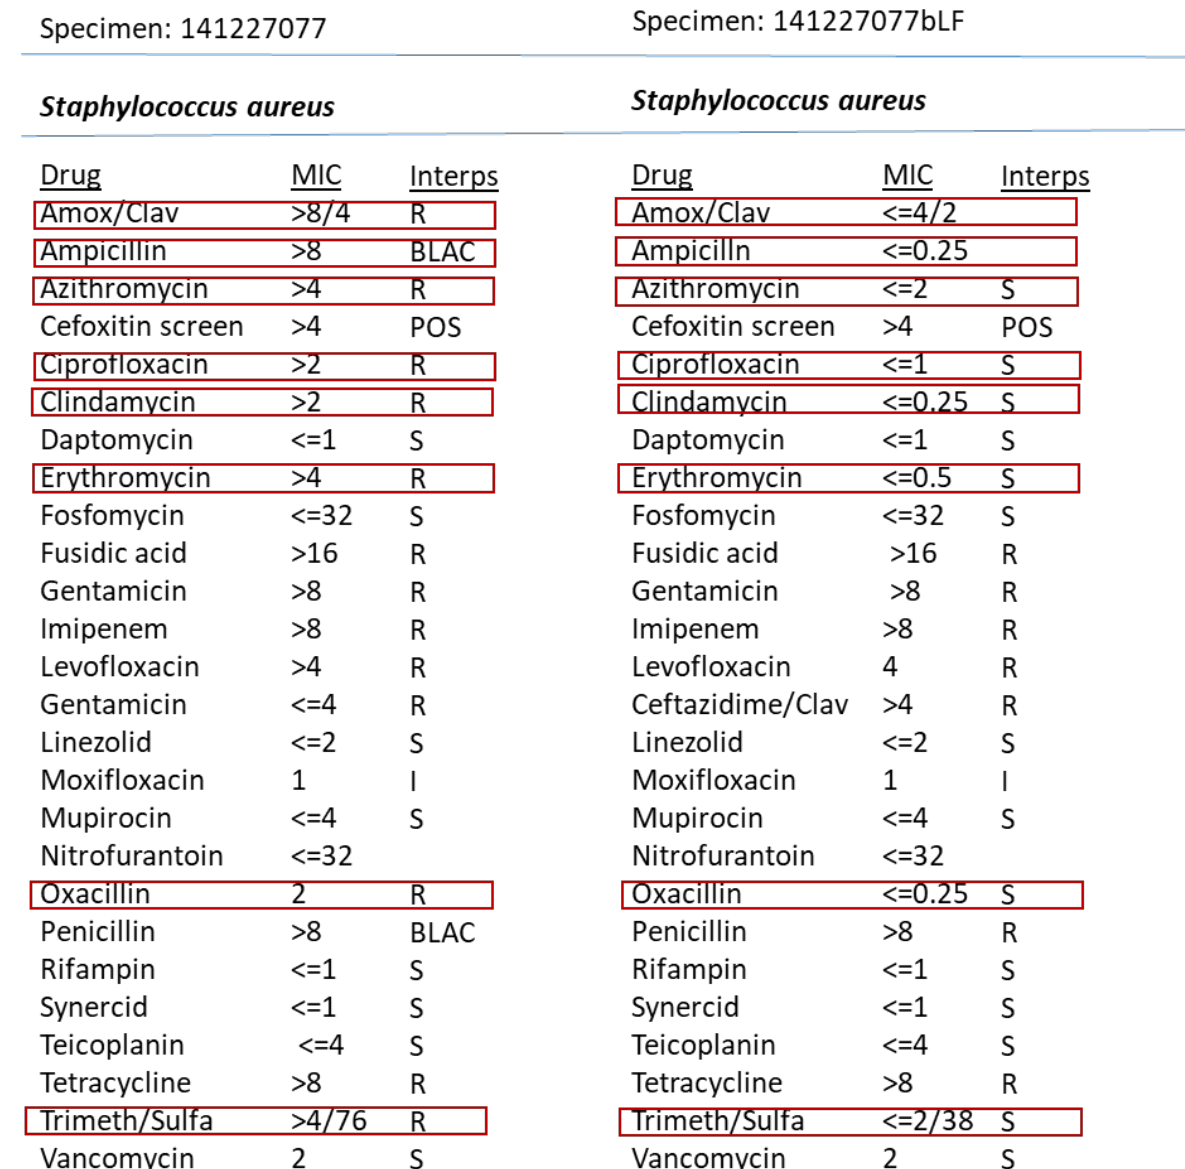
Figure 8. Demonstration of effect of bovine lactoferrin (bLF) on Methicillin resistant Staphylococcus aureus (MRSA)